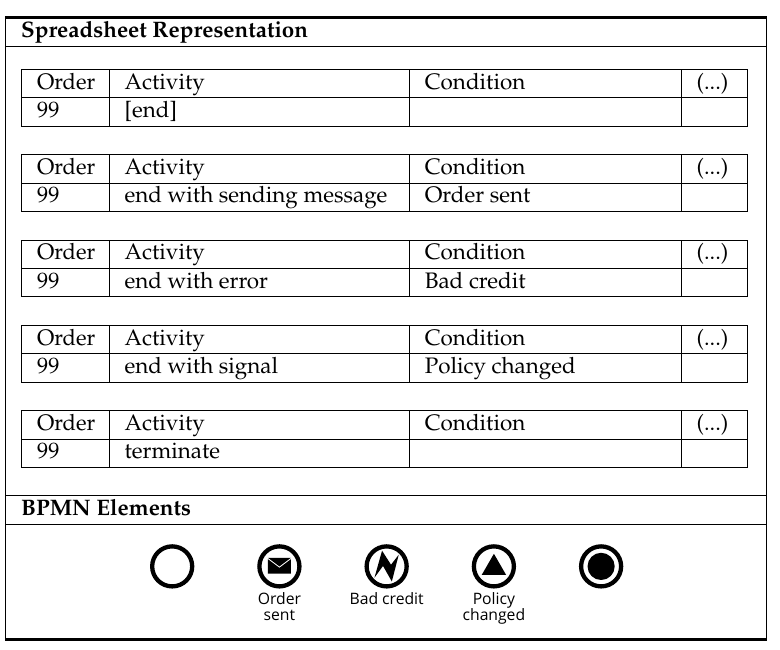
Table 8. End event